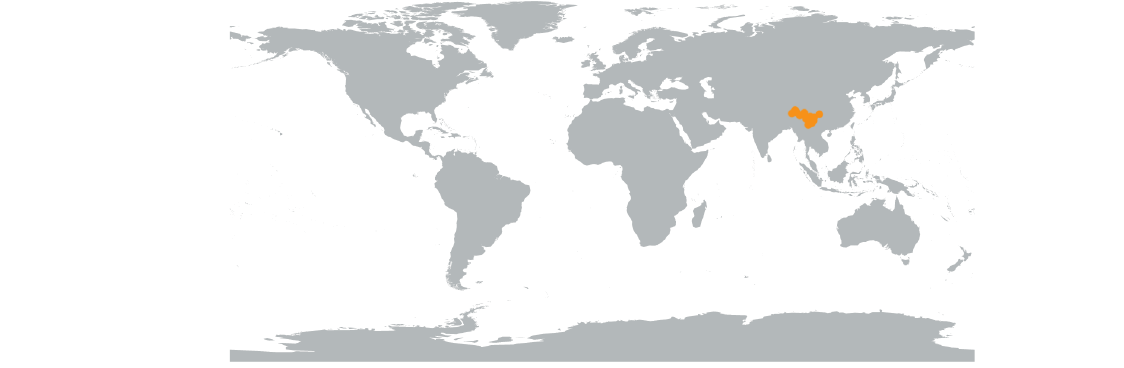
Fig. 45. Distribution of Malus ombrophila